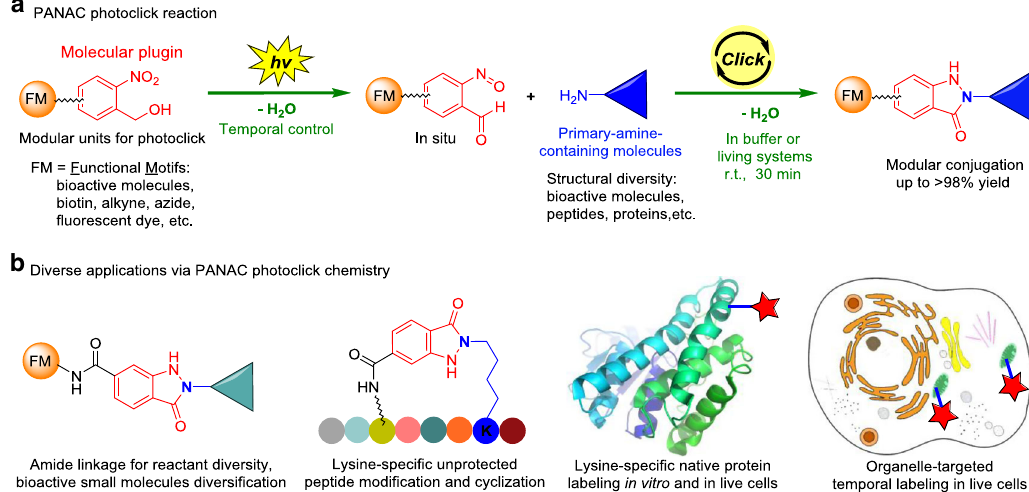
Fig. 1 Design of light-induced PANAC conjugation enables modular functionalization of small molecules and native biomolecules in temporal control. a o -Nitrobenzyl alcohol ( o -NBA) was designed as molecular plugin and amide formations, as general linkage to rapidly access diverse reactants as modular units, and primary amines as straightforward click handle for PANAC photoclick reaction in vitro and in living systems. b Diverse applications of this PANAC photoclick